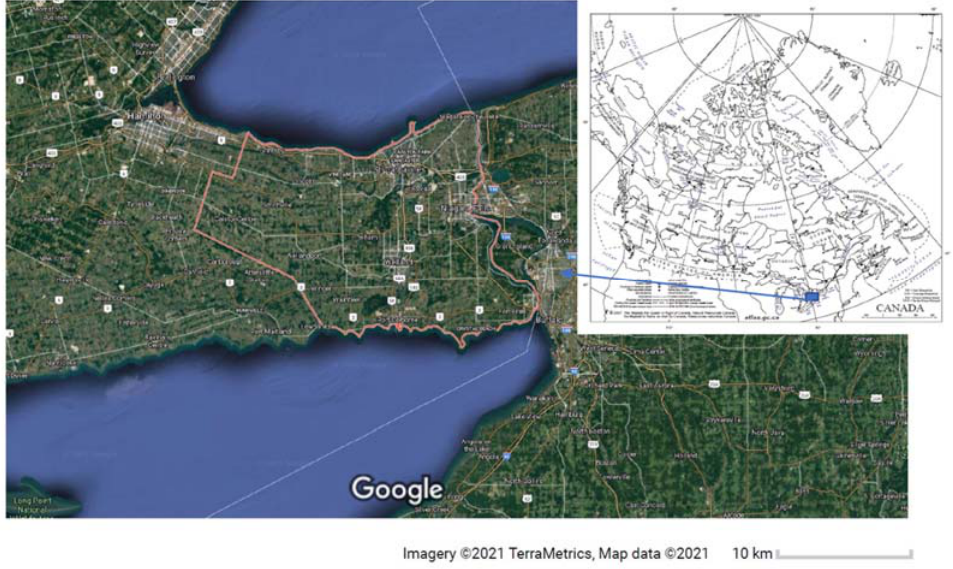
Figure 1. Map of the Niagara Region (Sources: map of Canada: Natural Resources Canada http://open.canada.ca/en/open-government-licence-canada; Niagara Region: Google Earth 2021, accessed on 20 May 2021) (43.06001, − 79.106667).